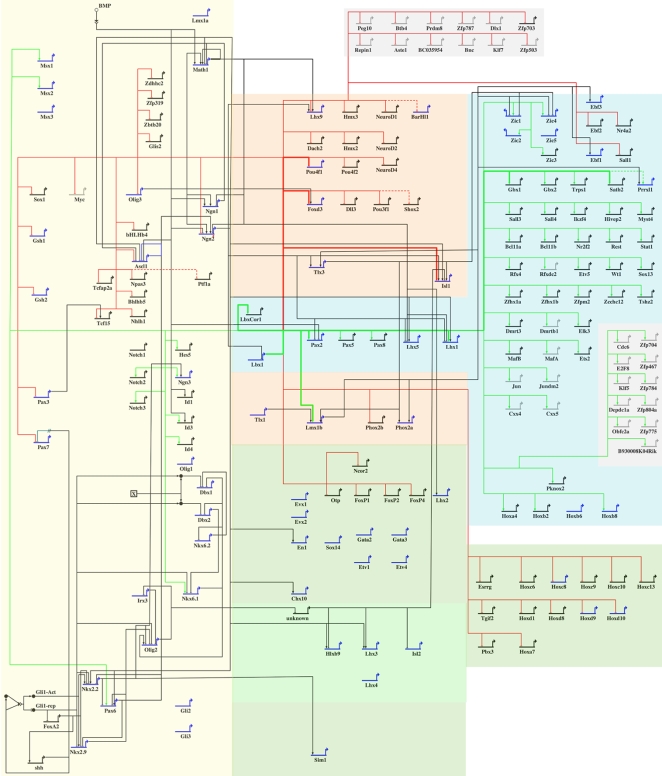
Draft GRN for Neural Tube Patterning.Biotapestry was used to create a View from the Genome from known (blue) and Lbx1-responsive (black or grey) SSTF nodes and their epistatic interactions. The shaded areas represent different regions of expression: ventricular zone (yellow); ventral postmitotic (green); dorsal commissural (salmon); dorsal association (blue); no expression information (grey). Epistatic relationships between nodes that have been published are shown in black. The epistatic relationships of Lbx1 that were discovered in this work are shown in green (activating) or red (repressing). Those that were previously known and confirmed in this work are shown as bold red or green lines. We emphasize that the interactions shown are genetic and do not represent direct molecular interactions. Few, if any, direct molecular interactions have been demonstrated in the neural tube literature.